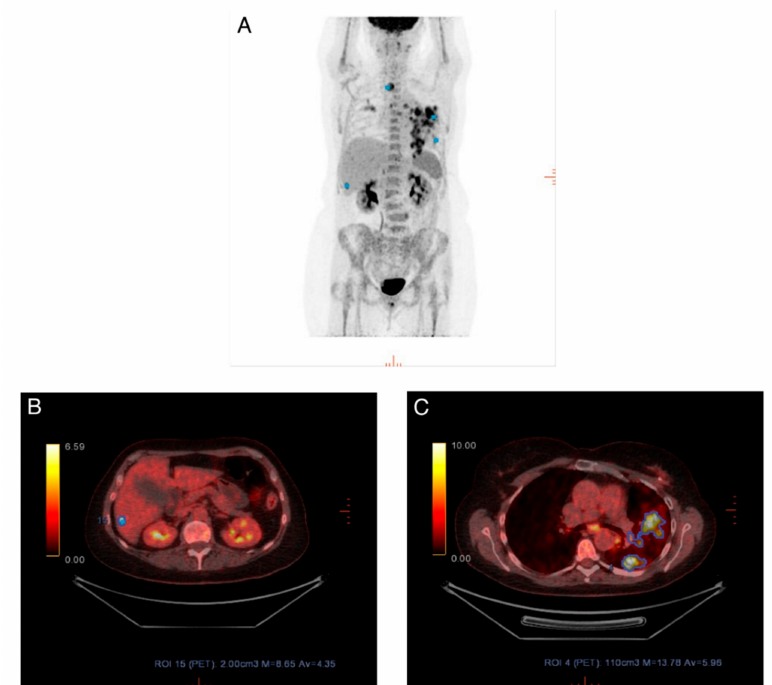
Figure 4. ( A ) Maximum intensity projection (MIP) for scan where di ff erent lesions were measured. ( B ) Rater 2 measured SUL peak in a lesion in the liver, as she interpreted the lung lesion as a non-metastatic lesion. ( C ) Rater 1 and rater 3 interpreted the lung lesion as metastatic and measured SUL peak in